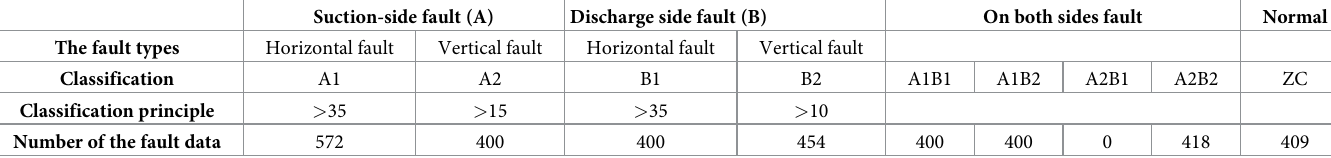
Table 3. Classification tables after data generation table.